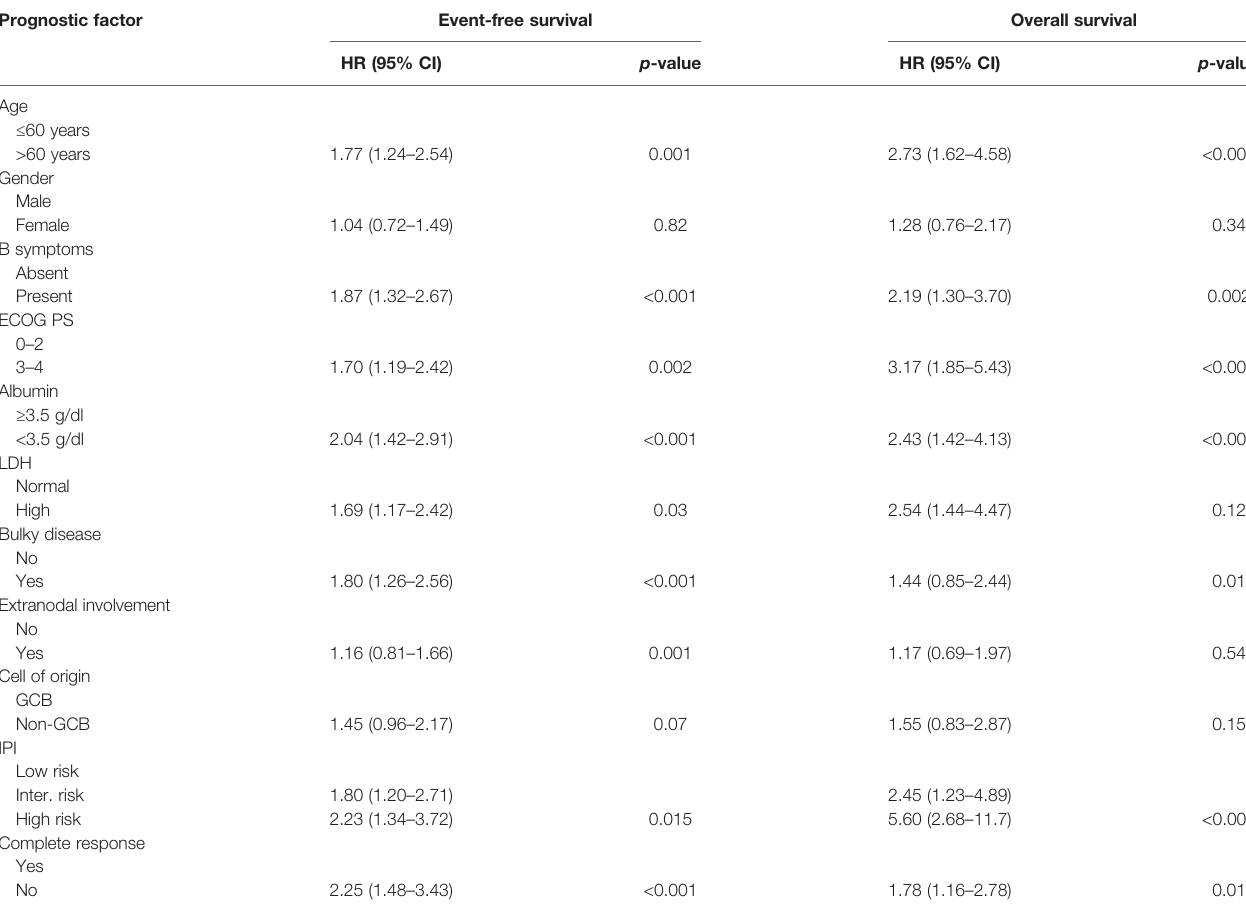
TABLE 2 | Univariate analysis of prognostic factors for event-free survival and overall